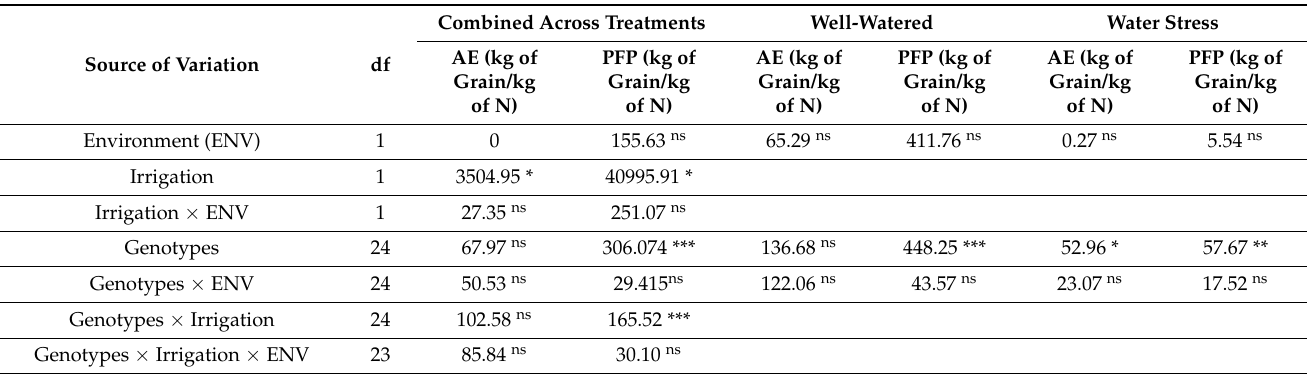
Table 3. Analysis of variance combined across environment of agronomic efficiency (AE) and partial factor productivity (PFP) analyzed in the diallel systems with six Algerian maize populations evaluated along with four checks in two environments in Algiers under both managed drought and nitrogen